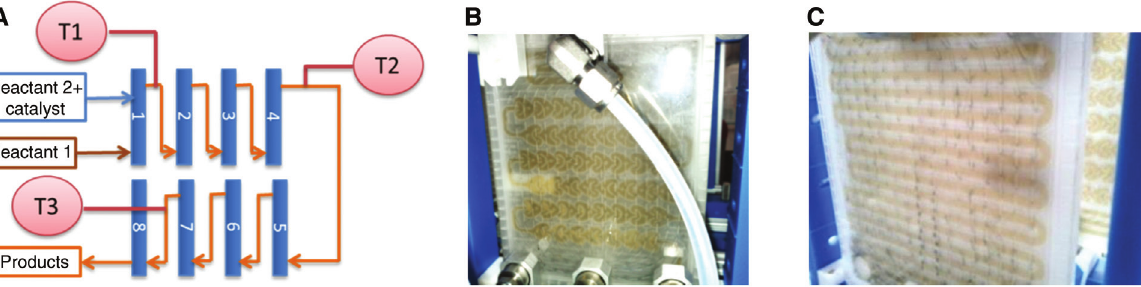
Figure 2 (A) Schematic diagram of the Corning module composed of eight plates. The sensors T1 to T3 are thermocouples. The reactants are introduced in the first plate and flow in series through the eight plates that are all mixing plates (B) except for plate 3, which is a serpen- tine channel (C).